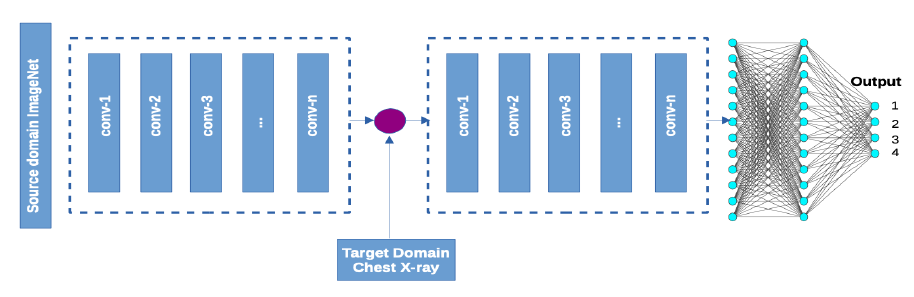
Figure 1. Proposed network architecture where convolution blocks in the left segment indicate pre-trained weights from the source domain which remain frozen and the right indicates the frozen base layers with trainable fully connected layers with a top Softmax